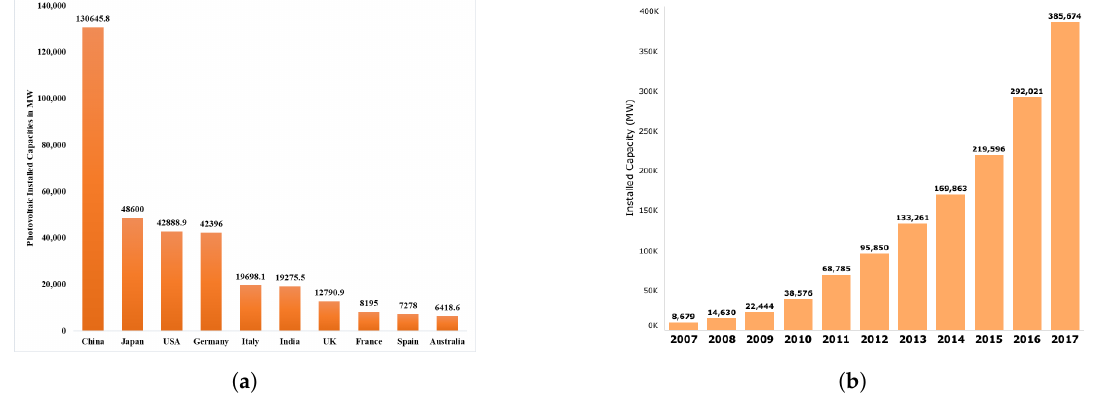
Figure 1. ( a ) Top 10 PV installed capacities in the world; ( b ) Total PV installation across the globe from